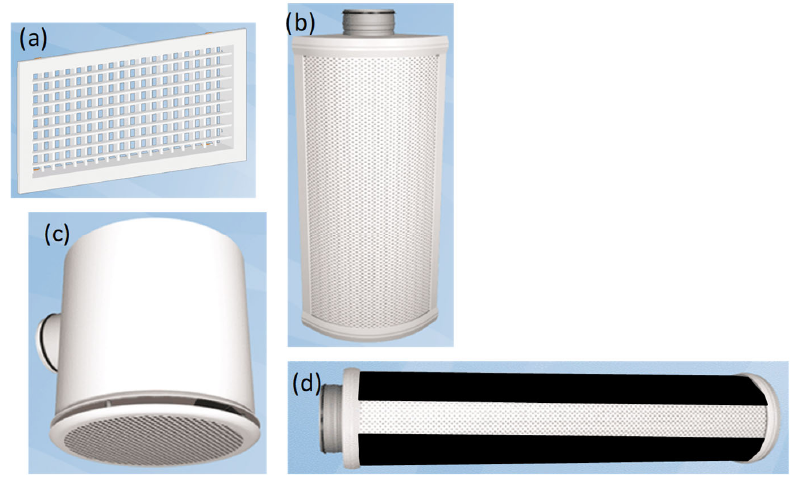
Figure 1. Air diffusers: ( a ) corridor wall-grille, ( b ) displacement ventilation unit, ( c ) mixing ventila- tion, and ( d ) perforated duct diffuser.